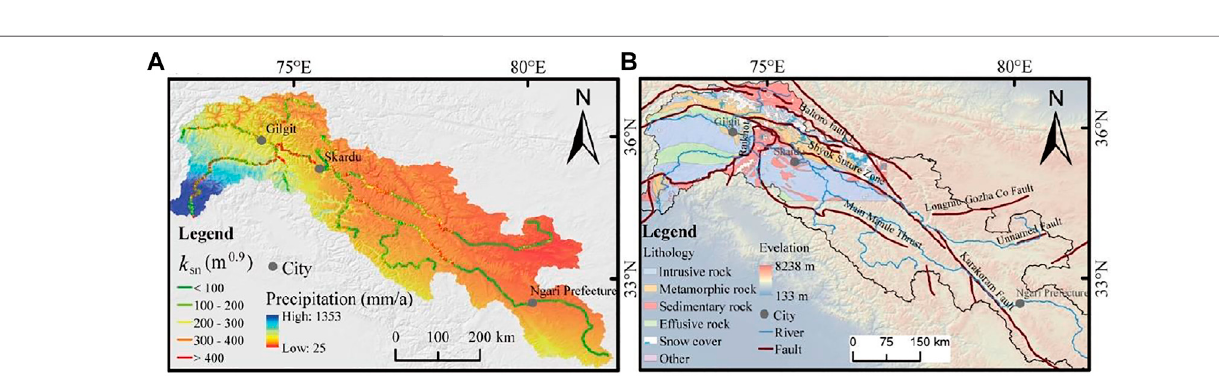
FIGURE 2 | Precipitation and geology of the study area. (A) Normalized channel steepness ( k sn ) and average annual precipitation (1970 – 2000) in the upper Indus River (Precipitation data are c. 1 km 2 resolution, from http://www.worldclim.org/version2): (B) Regional geological map (resolution 1:1,000,000, from http://www.ngac.